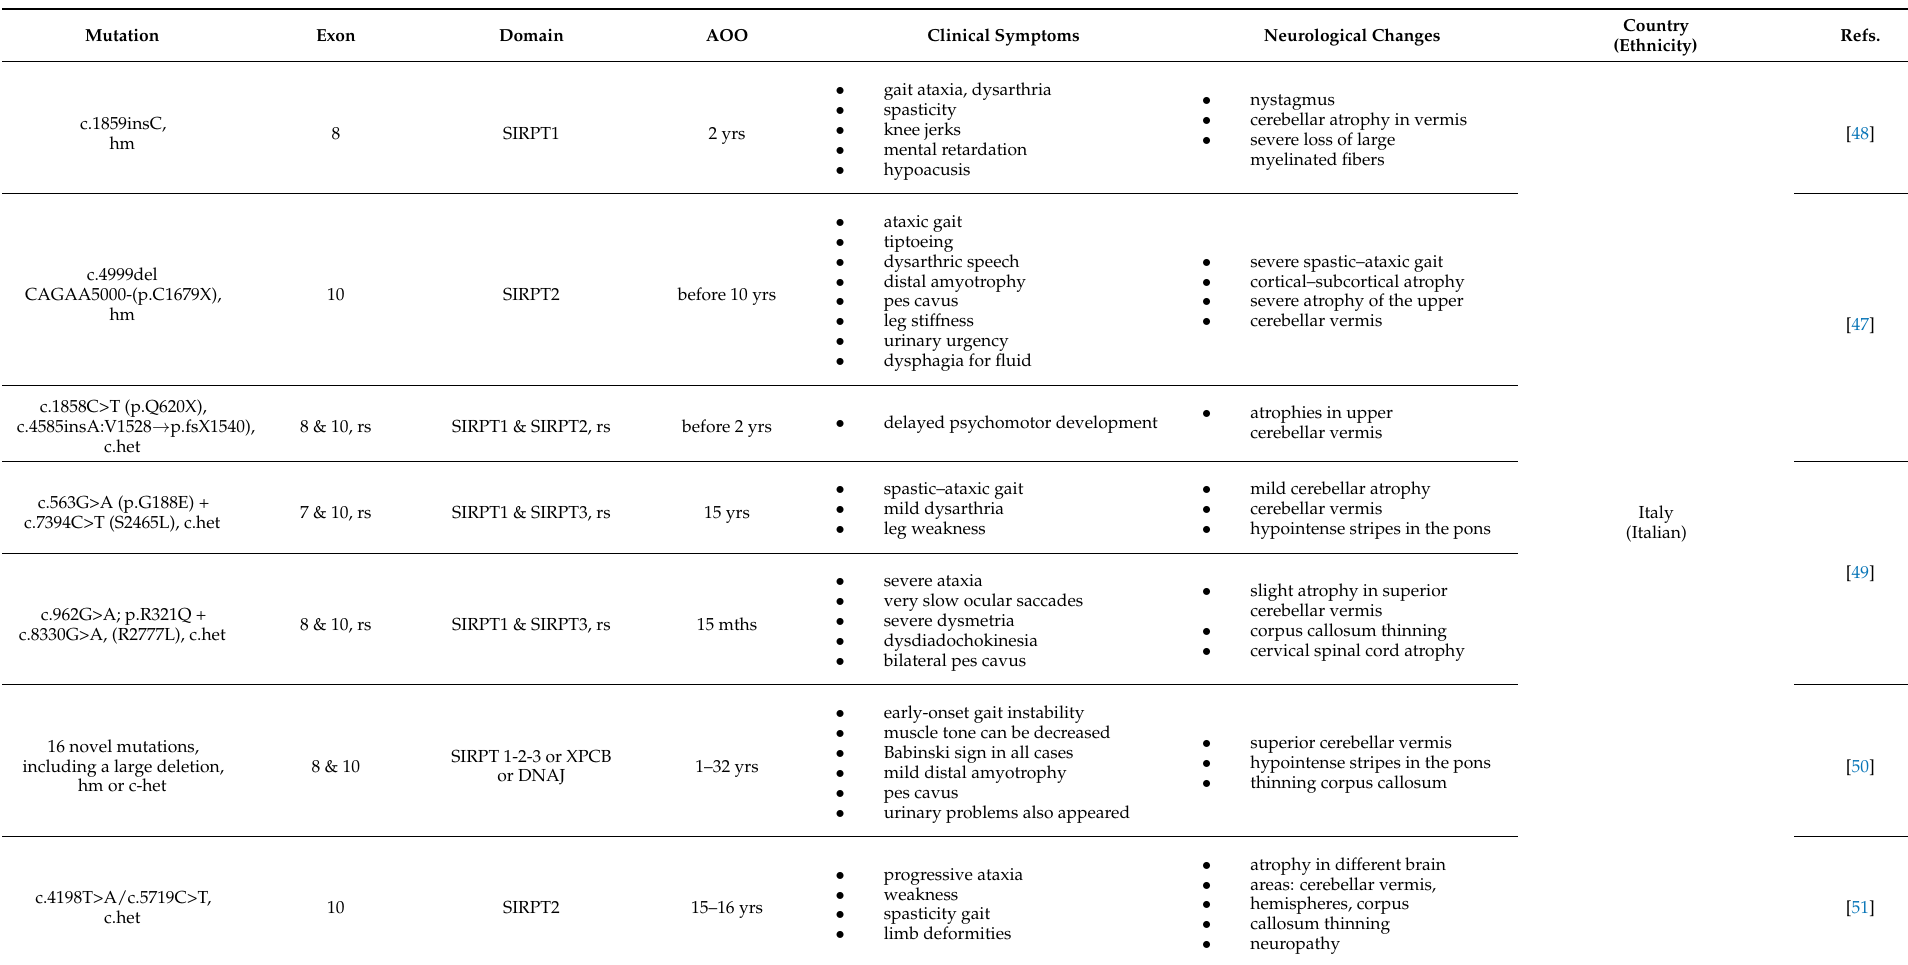
Table 2. SACS mutation cases discovered in Europe. “hm” means mutation carried the homozygous form, “c het” means mutation had compound heterozygous allele. “rs” means